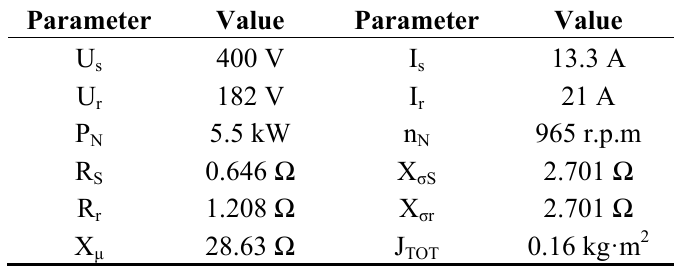
Table 2. Specifications of the DFIG system used in the laboratory tests.